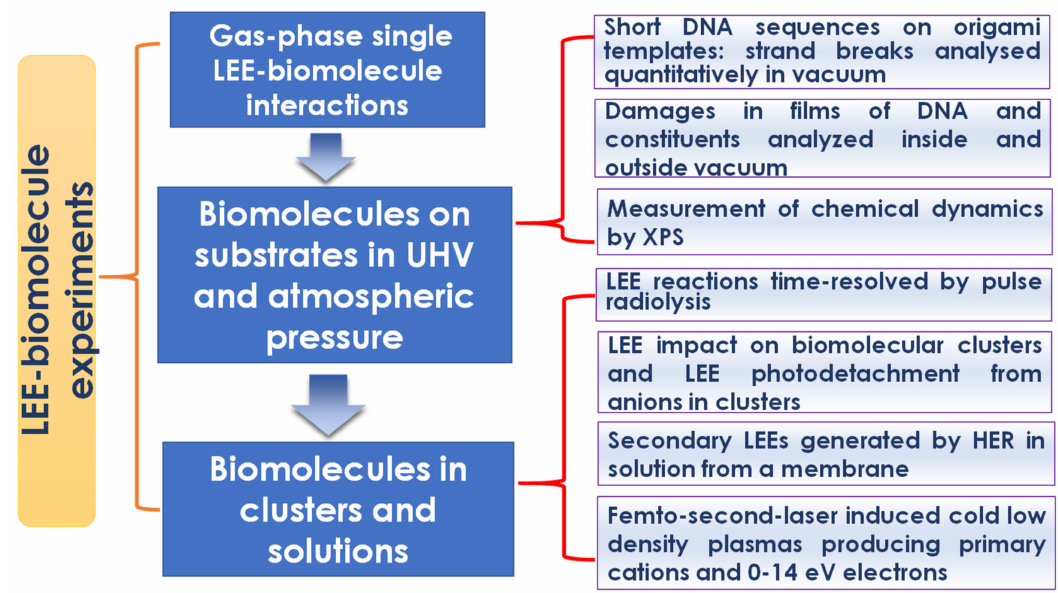
Figure 1. Scope of experimental investigations on the interaction of LEEs with biomolecules and